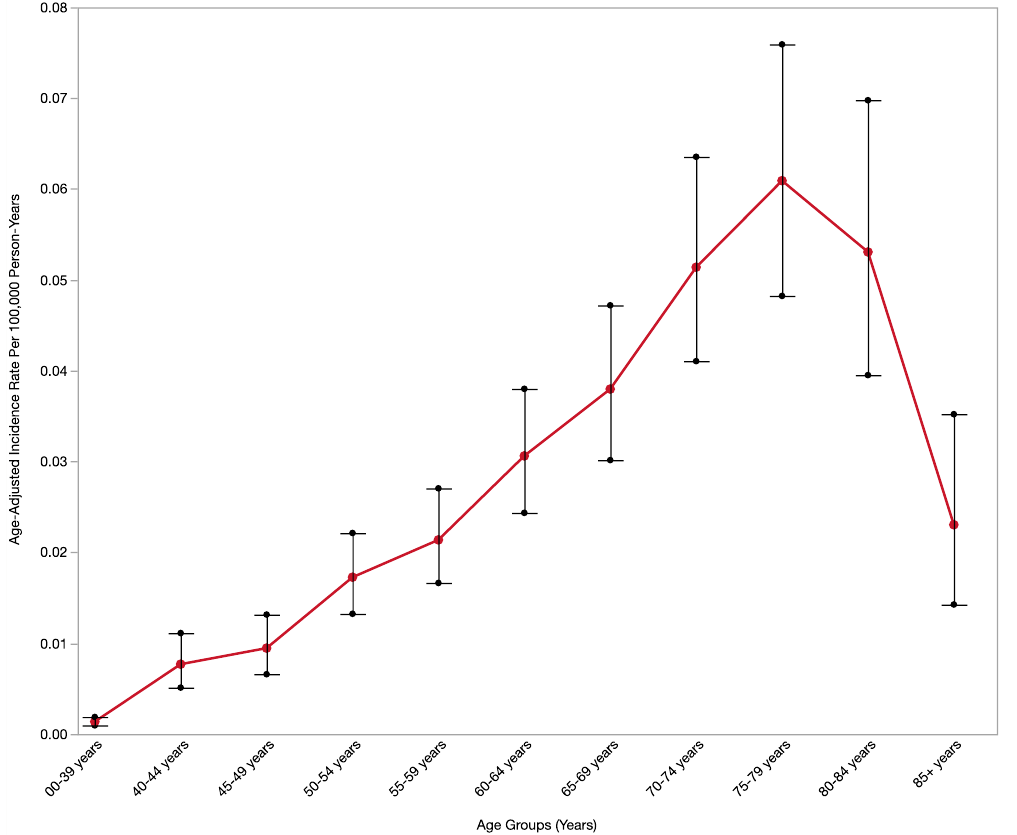
Figure 1. MANEC-P incidence rate by age groups. The red dots and line connect the age-adjusted incidence rate per 100,000 person-years for each age group and the black bars are the 95% confidence interval around each age-adjusted incidence rate for each age group.